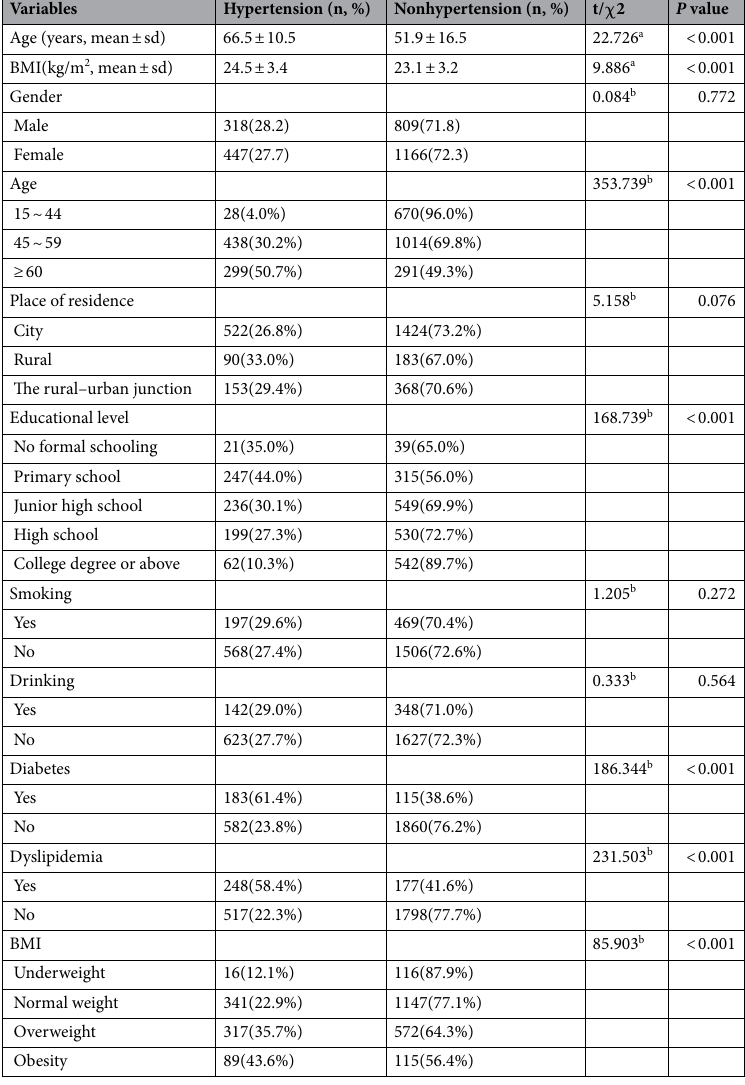
Table 1. Analysis of basic characteristics of hypertension and nonhypertension. a Student’s t-test, b Chi-square test; BMI: body mass